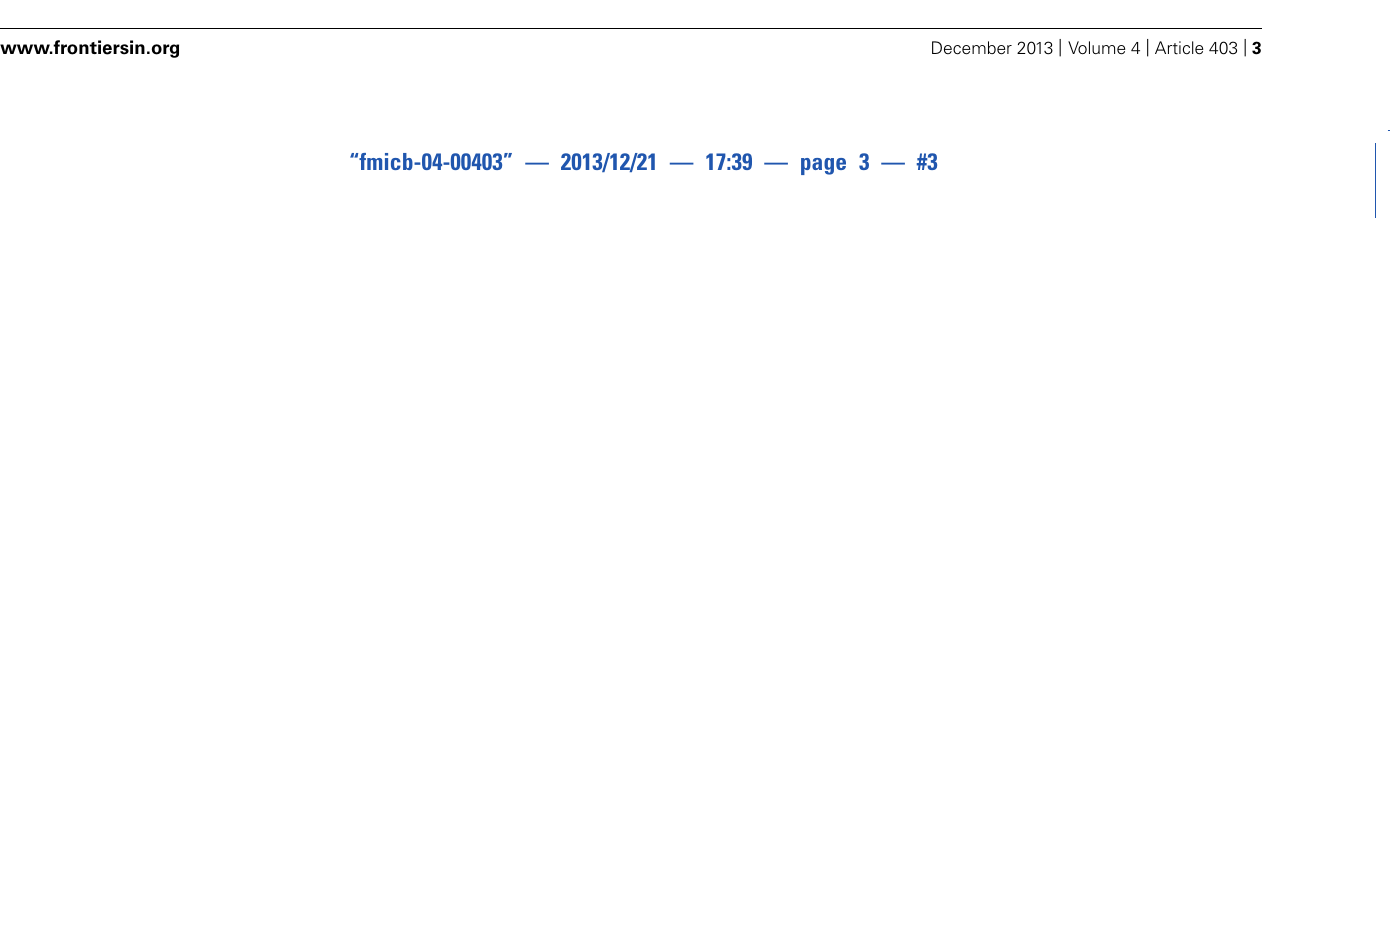
their roles in N-glycosylation, these proteins were re-annotated as Agl5–Agl15 (Kaminski et al.,